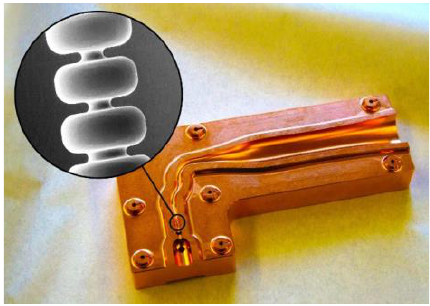
Figure 18. SLAC mm-wave linac prototype for high-power testing.